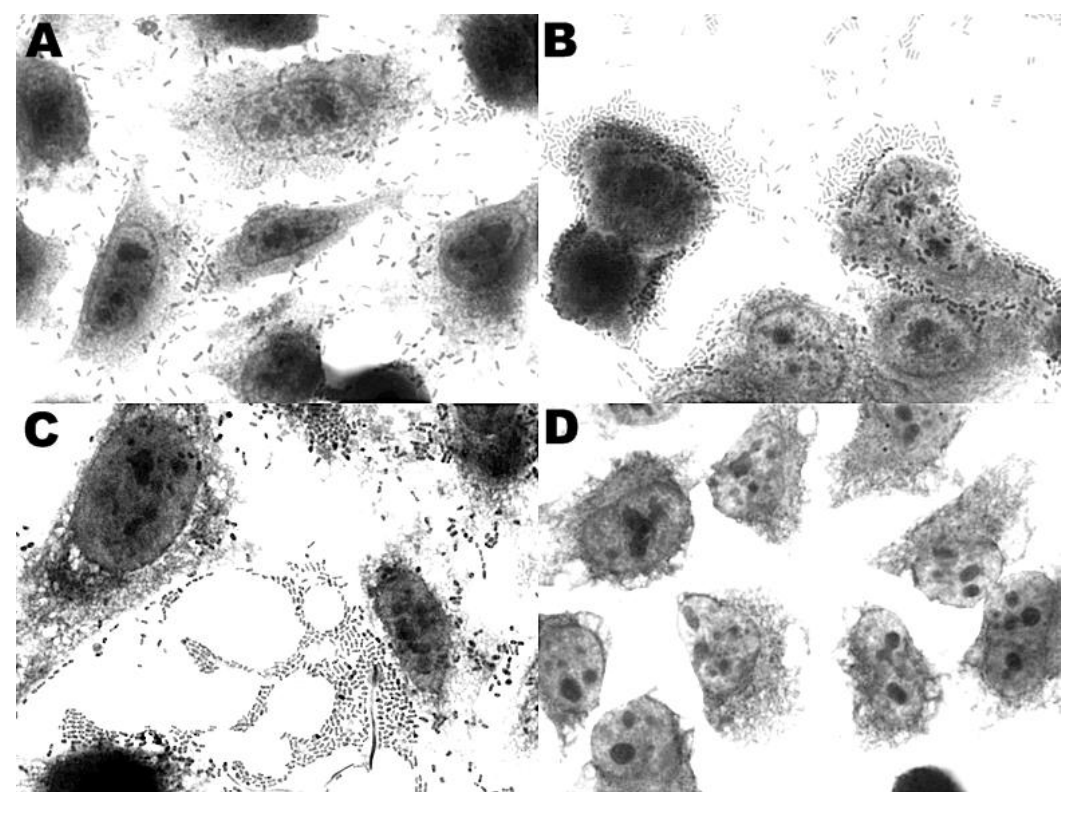
Figure 1. Adherence of E. coli isolated in this study (microscope magnification of 1000×): ( A ) and ( B ) OF-39 strain showing diffuse adherence and aggregative adherence on HEp-2 cells; ( C ) OF-9 EAEC strain showing aggregative adherence on HEp-2 cells and ( D ) K12 Hb101 negative control of adherence